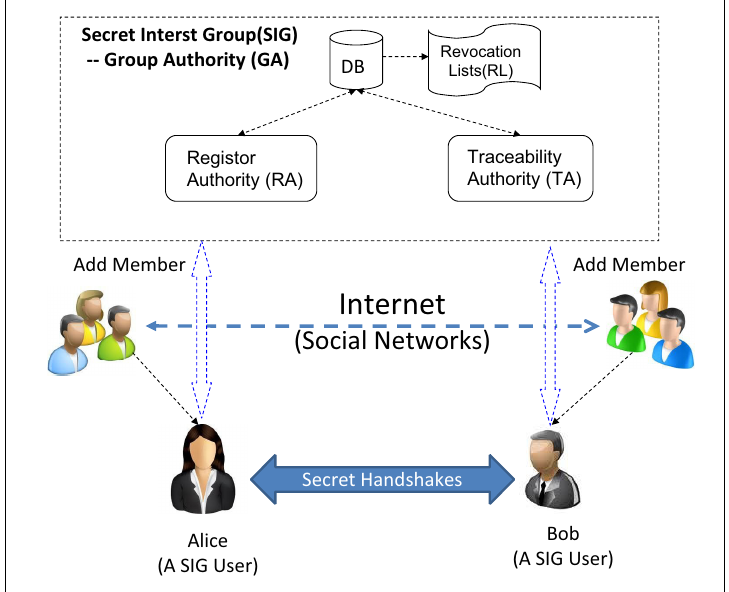
Figure 1. An illustration of practical secret handshake